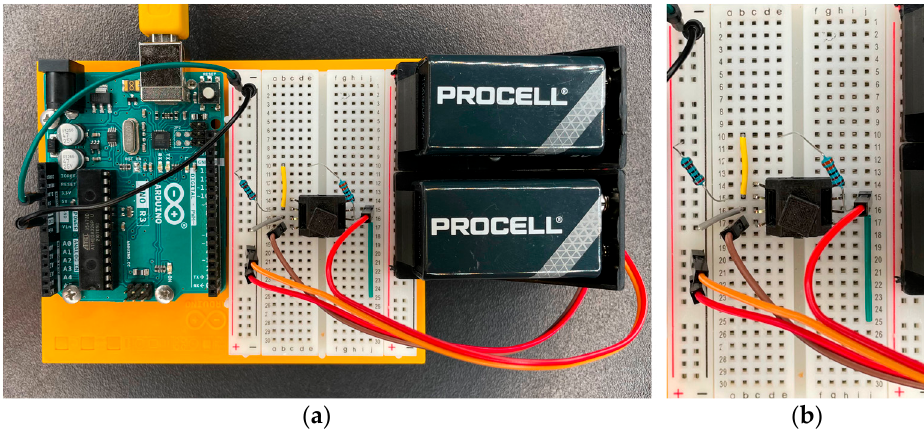
Figure 6. ( a ) Constructed inverting ampli fi er circuit. ( b ) Close view of design used on a breadboard.